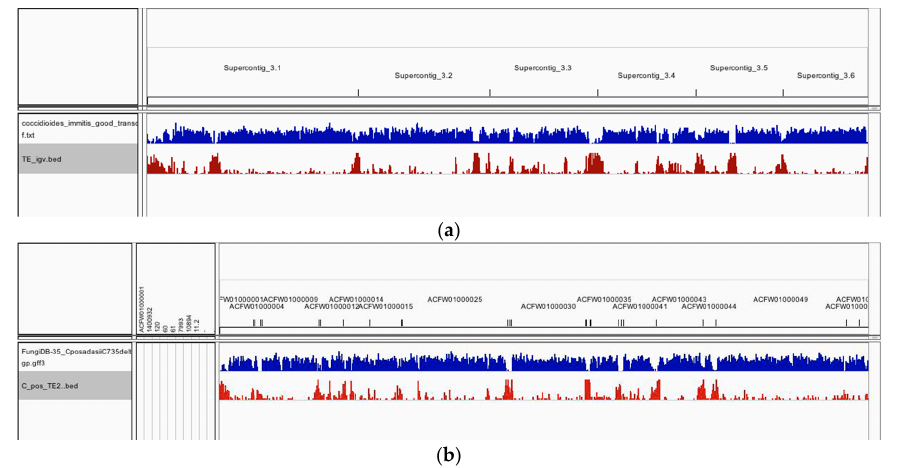
Figure 2. The genomic distribution of protein-coding loci (blue track) and the TEs (red track) in C . immitis ( a ) and C . posadasii ( b ) assemblies. These data show an inverse relationship between predicted genes and TEs and the tendency of TEs to cluster at the ends of contigs, reflecting both assembly difficulties and potential preferential accumulation regions. The C . immitis genome is mapped on six contigs; C . posadasii on 20.